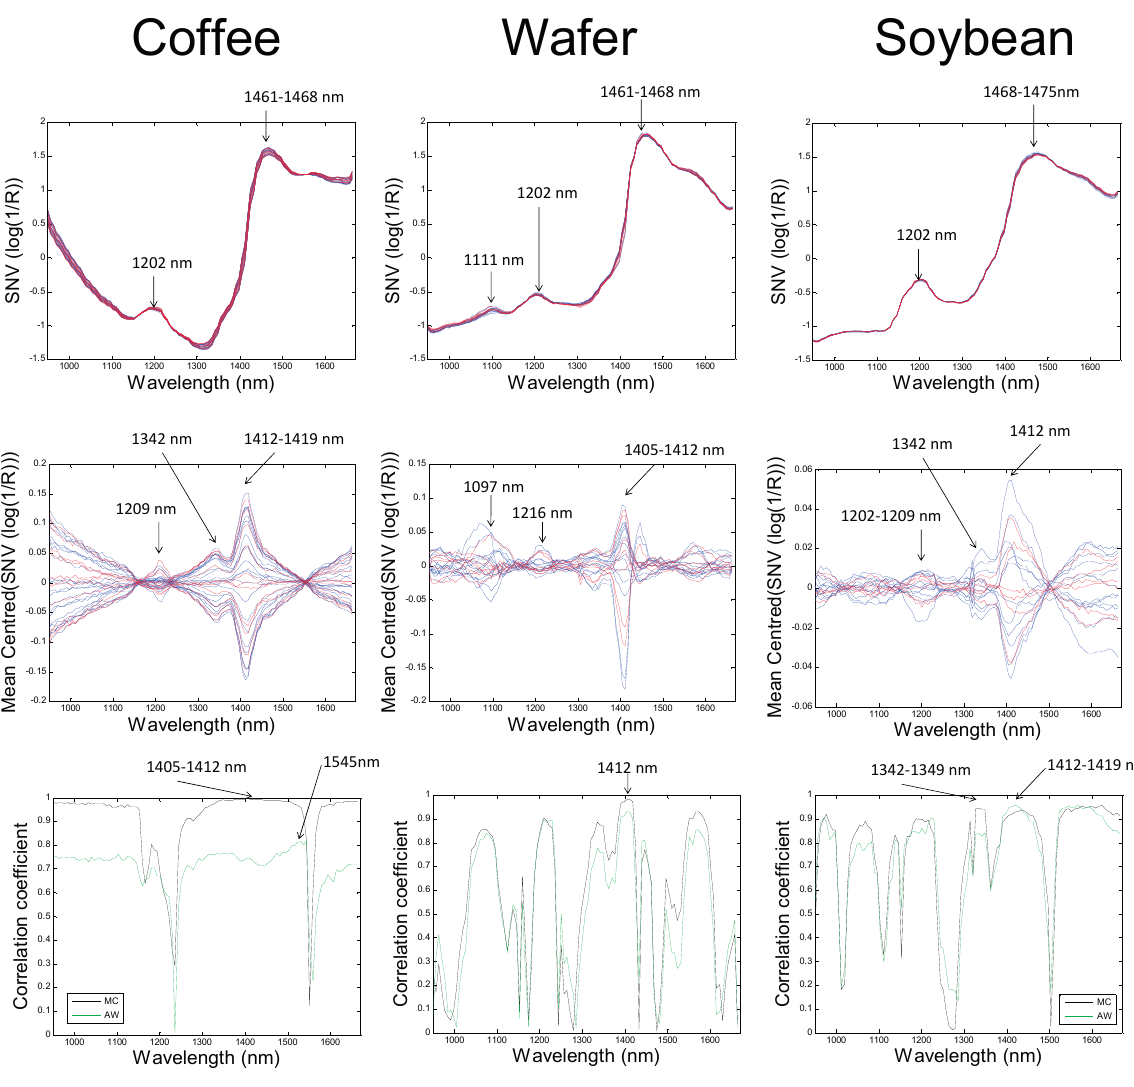
Figure 2. Top row: Standard normal variate (SNV(log(1/R))) pre-treated mean spectra; middle row: Mean centred SNV spectra (obtained by subtracting the mean SNV(log(1/R) spectrum from each group) of each food sample studied. Blue spectra represent calibration set and red spectra represent independent test set. Bottom row: Absolute value of correlation between SNV(log(1/R)) at each wavelength and moisture content (MC, black line) or water activity (aw, green